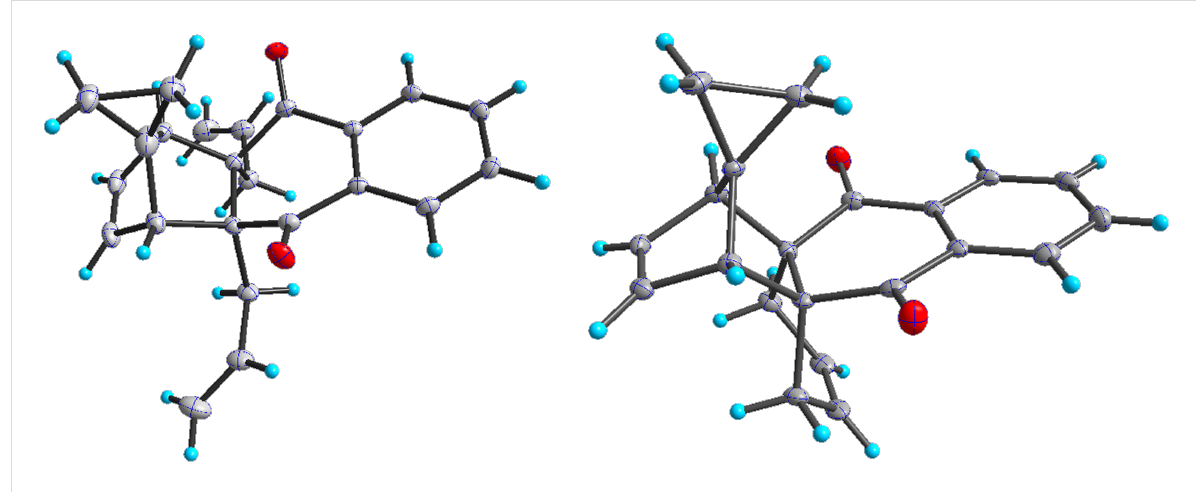
Figure 4: The molecular structures of the compounds 2b (left) and 1b (right) showing 30% displacement ellipsoids.